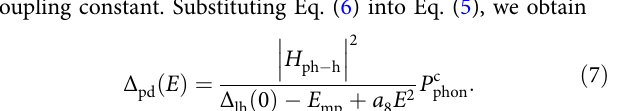
175 µeV, U 0 = 0.7 V, and U 1 = 1.8 V. For the polarization measurements the amplitude A in Eq. (8) is dimensionless. The solid line in Fig. 2d fi ts the polarization amplitude data in cw mode for A = 2.2%, U 0 = 0.8 V, and U 1 = 1.8 V. The time- in phon